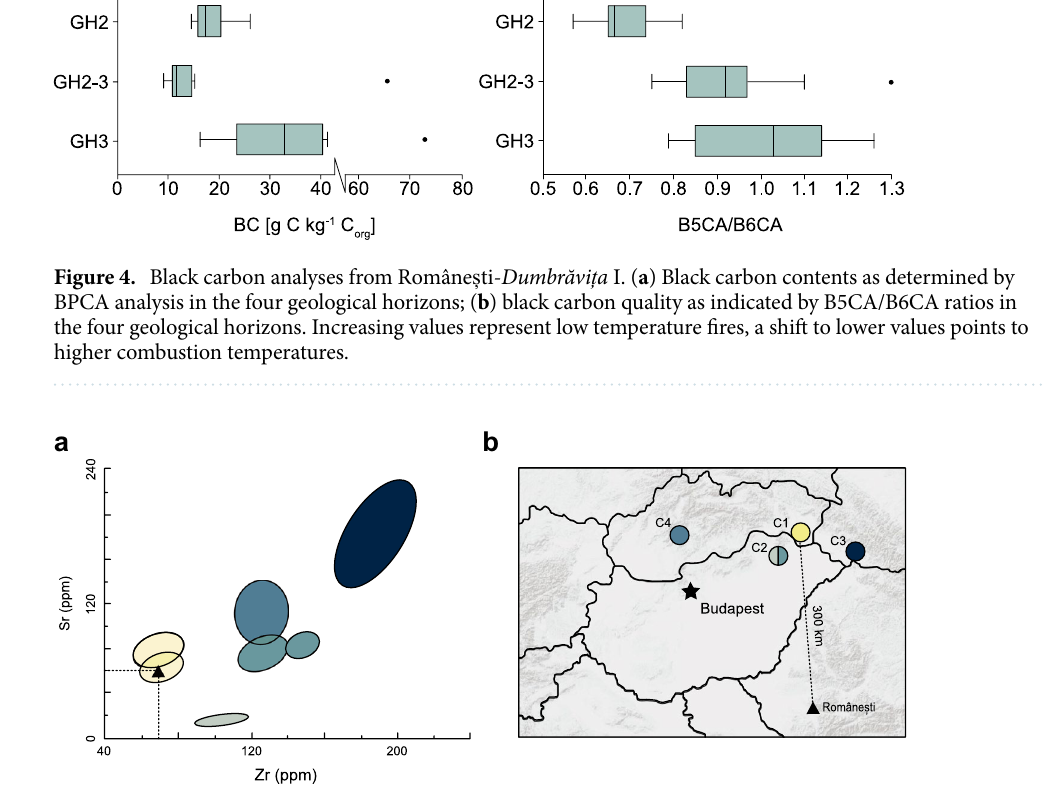
Figure 5. Source of the obsidian artifact from Române ș ti- Dumbrăvi ț a I, GH3. ( a ) Bivariate plot of 90% confidence intervals of Zr and Sr concentrations of Carpathian obsidian sources 47 and the single obsidian artifact from Române ș ti; ( b ) map of Carpathian obsidian sources and the site of Române ș